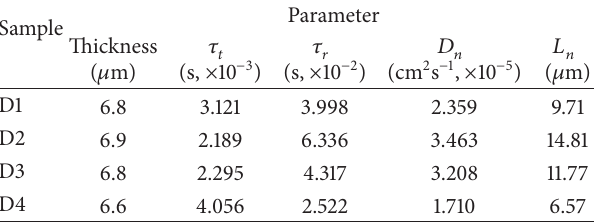
Table 3: Charge transport parameter of the chitosan sol-based DSSCs.